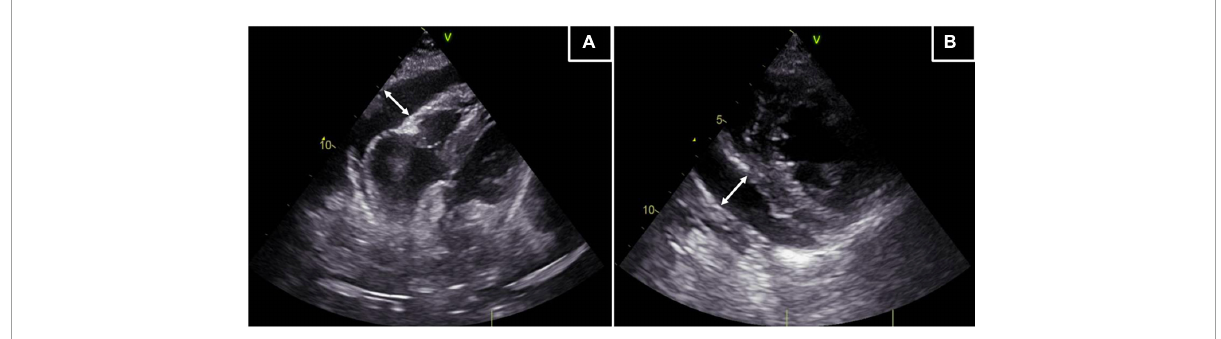
FIGURE1 Transthoracic echocardiography. The TTE reveals a circumferential PE of moderate entity (max 17 mm). (A) Off-axis 4 chamber apical view of the epicardial effusion. (B) Parasternal short axis view of the epicardial effusion. White lines with arrows: extension of the PE.